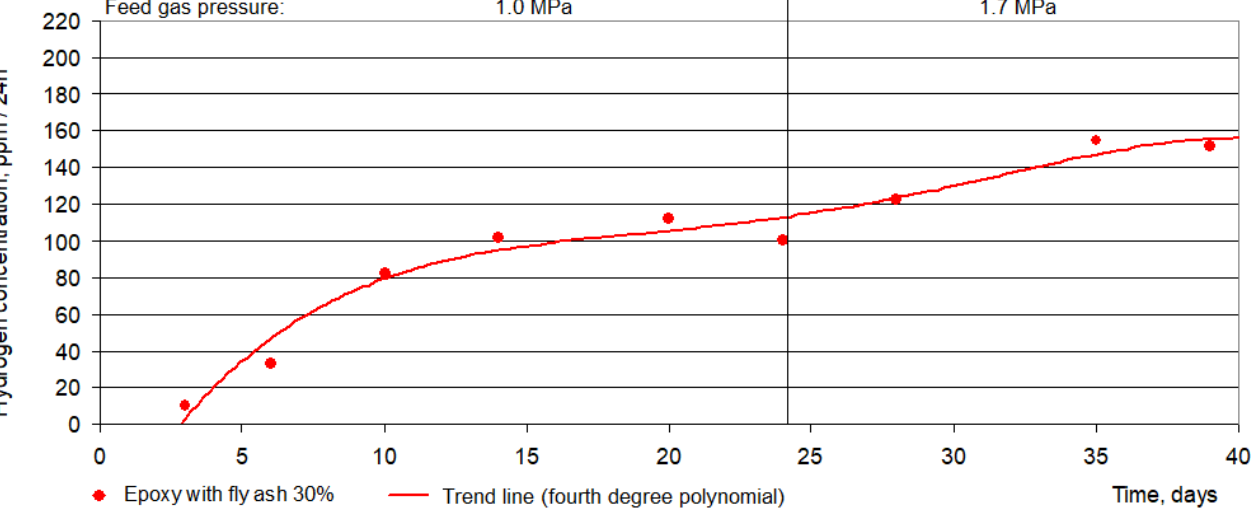
Figure 3. Increase of hydrogen concentration during the Carrier Gas Method test of epoxy resin with fly ash (30% vol.) with 1.0 MPa and 1.7 MPa feed gas pressure.